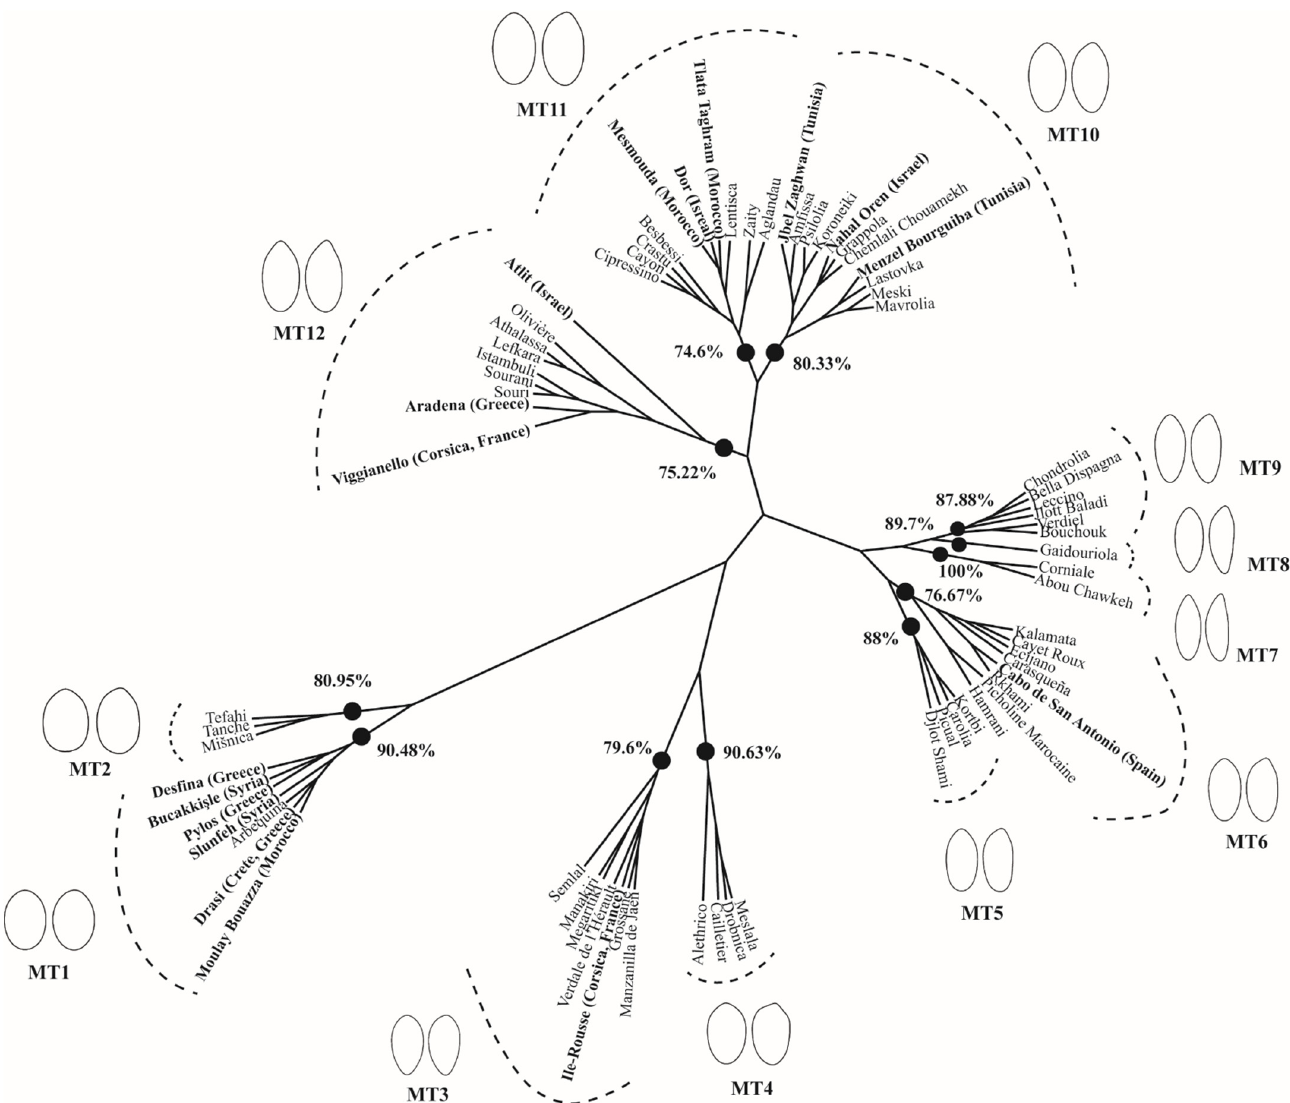
Figure 4. Hierarchical clustering obtained on the supposed wild olive populations and varieties. Discriminant rate (%) and reconstructed size-standardized stone shape in dorsal (left side) and lateral view (right side) of the 12 identified morphotypes are shown. Supposed wild populations are written in boldface.